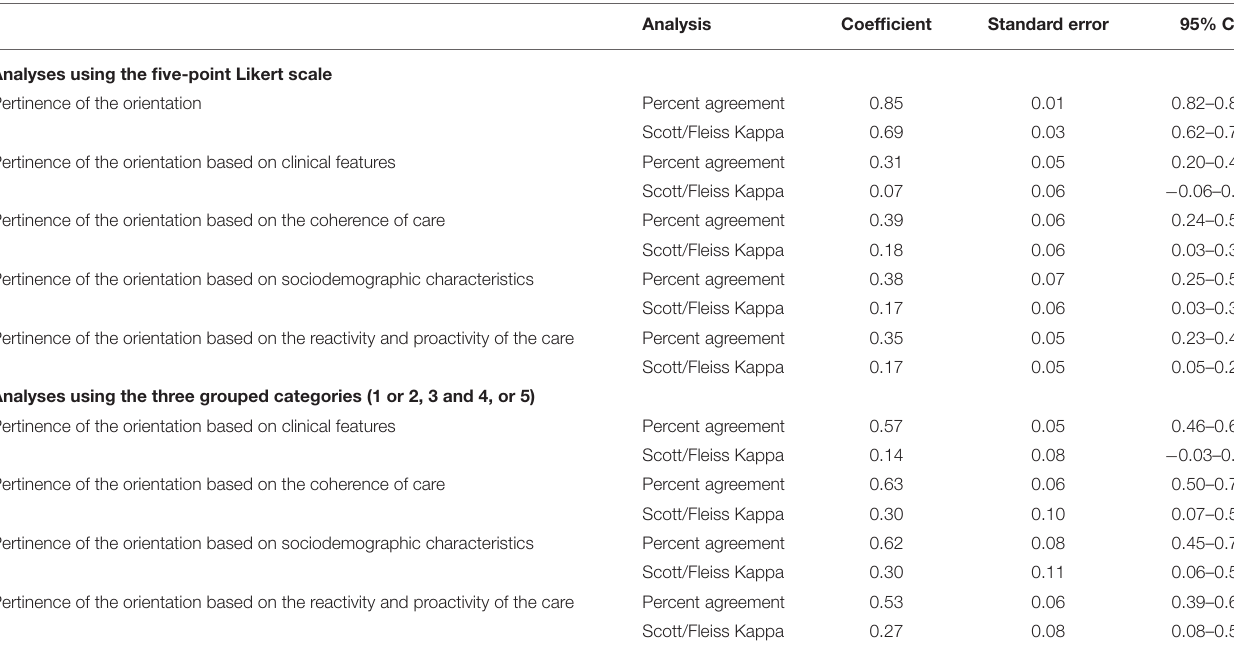
TABLE 1 | Inter-expert agreement: Likert-scale evaluations of the pertinence of the orientations and in the responses to questions two, three, four, and